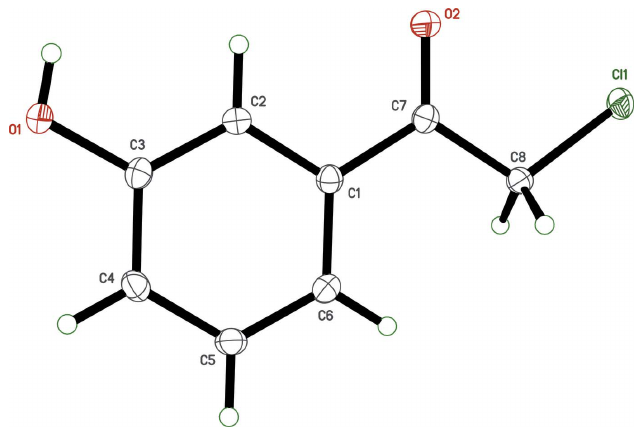
Figure 1 An ellipsoid plot (50% probability) of I . Hydrogen atoms are drawn as small